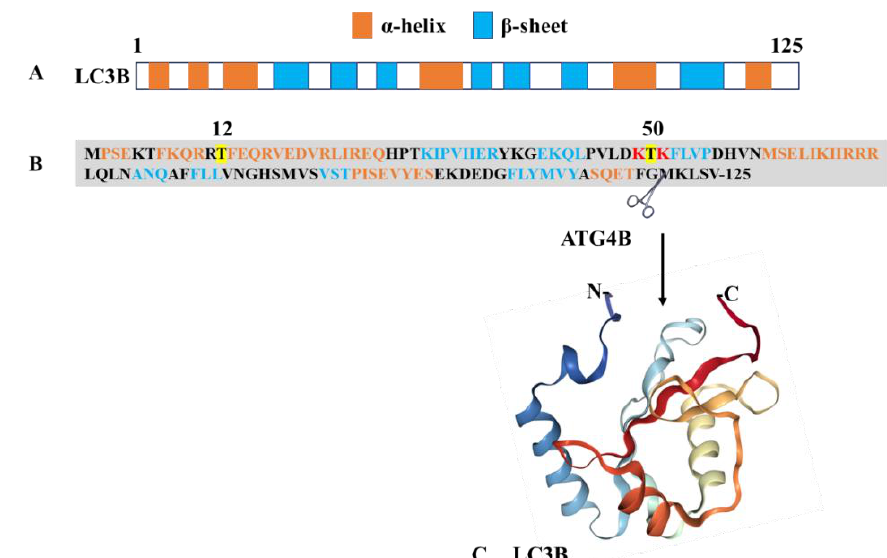
Figure 1. Structure of MAP1LC3B. The protein presents as a monomer with a molar mass of 13.6 kDa. ( A ) Pictorial illustration showing the alignment of α -helices and β -sheets in LC3B. ( B ) Primary structure of MAP1LC3B (NCBI reference ID: NP_073729.1) showing the positions of α -helixes and β -sheets. The sites of phosphorylation and acetylation are highlighted in yellow and red, respectively. The UbI domain is located at the C-terminus of the protein. ( C ) Three-dimensional (3D)-structure (PDB ID: 1V49) of the MAP1LC3B fragment 1 – 120. Figure generated using https://www.rcsb.org/, ref. doi:10.1093/bioinformatics/bty419.